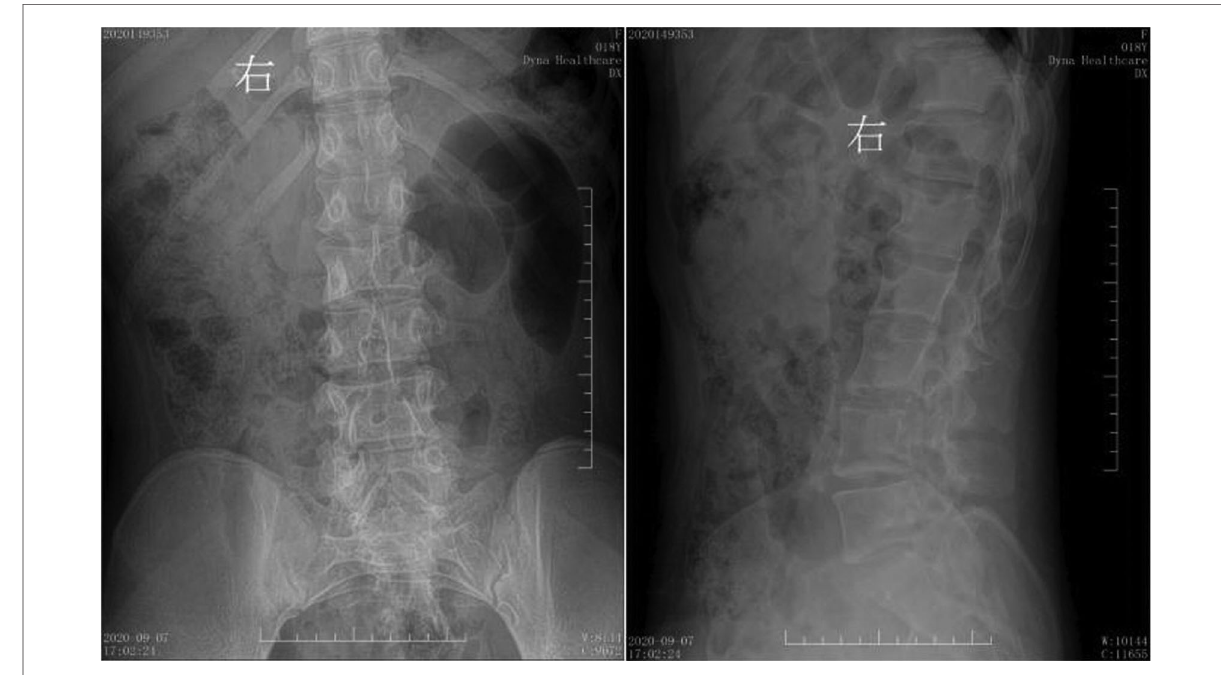
FIGURE 3 Preoperative digital radiography. Spina bi fi da is shown in the lumbar spine, with the L3 spinous process extending into the spinal